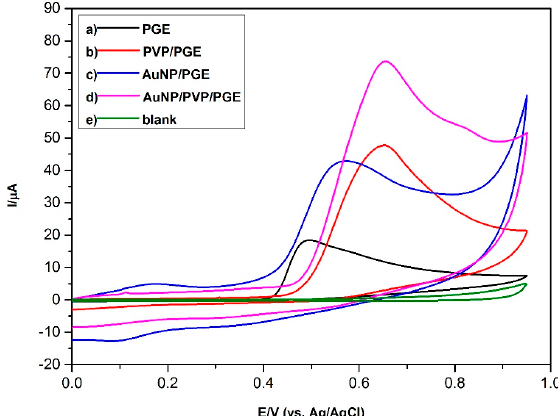
Figure 3. Cyclic voltammograms of 0.1 mM Bisphenol A (BPA) at: (a) bare PGE; (b) PVP-modified PGE; (c) AuNP-modified PGE; (d) AuNP/PVP-modified PGE; (e) absence of BPA at bare PGE. Conditions: pH: 7.0 (0.1 M Phosphate buffer solution (PBS)); scan rate: 100 mV/s − 1 ; E initial (Ei): 0.00 V; E final (Ef): 0.95 V.